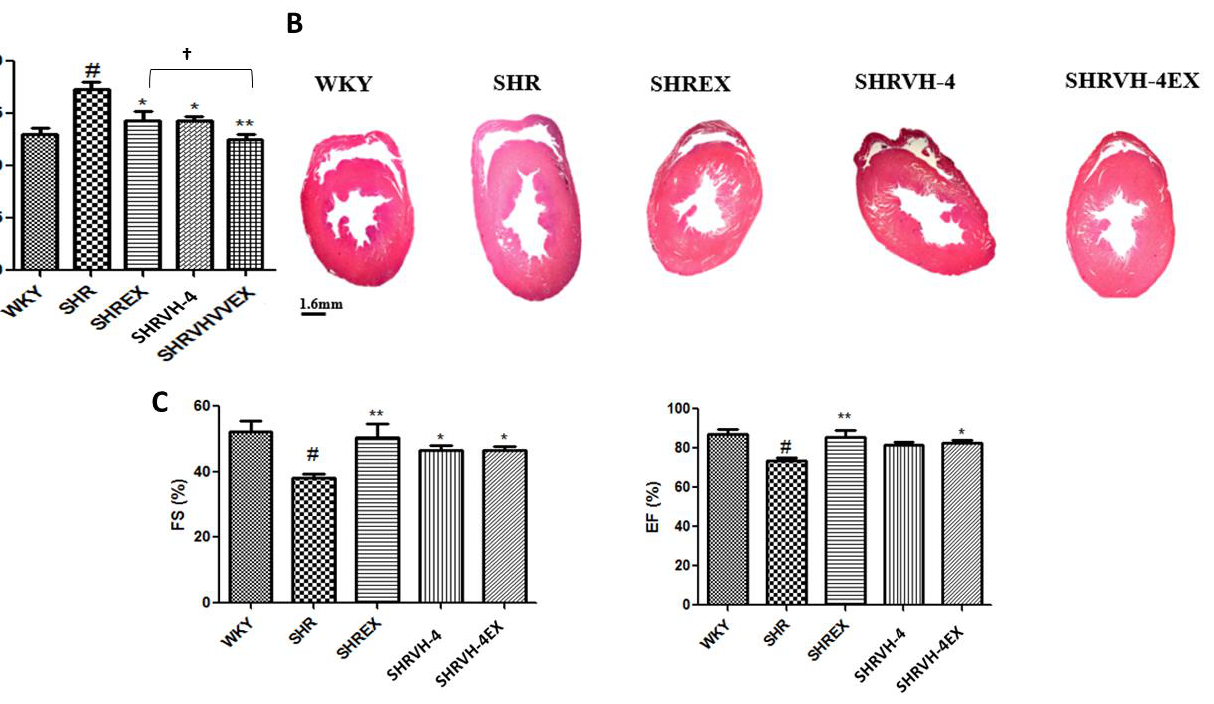
Figure 1. Effect of combination of VH-4 peptide and exercise on heart weight, ejection fraction (EF), and fractional shortening (FS) of SHR rats. ( A ) Heart weight, ( B ) ejection fraction % and fractional shortening %, ( C ) tomography of the cardiac tissue section. # p < 0.01 compared to WKY, * p < 0.05,